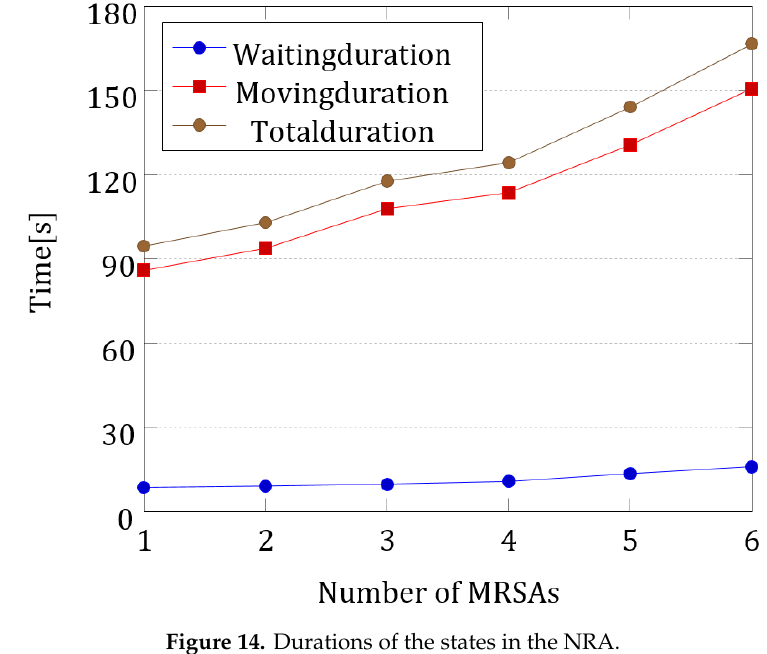
Figure 14. Durations of the states in the NRA.